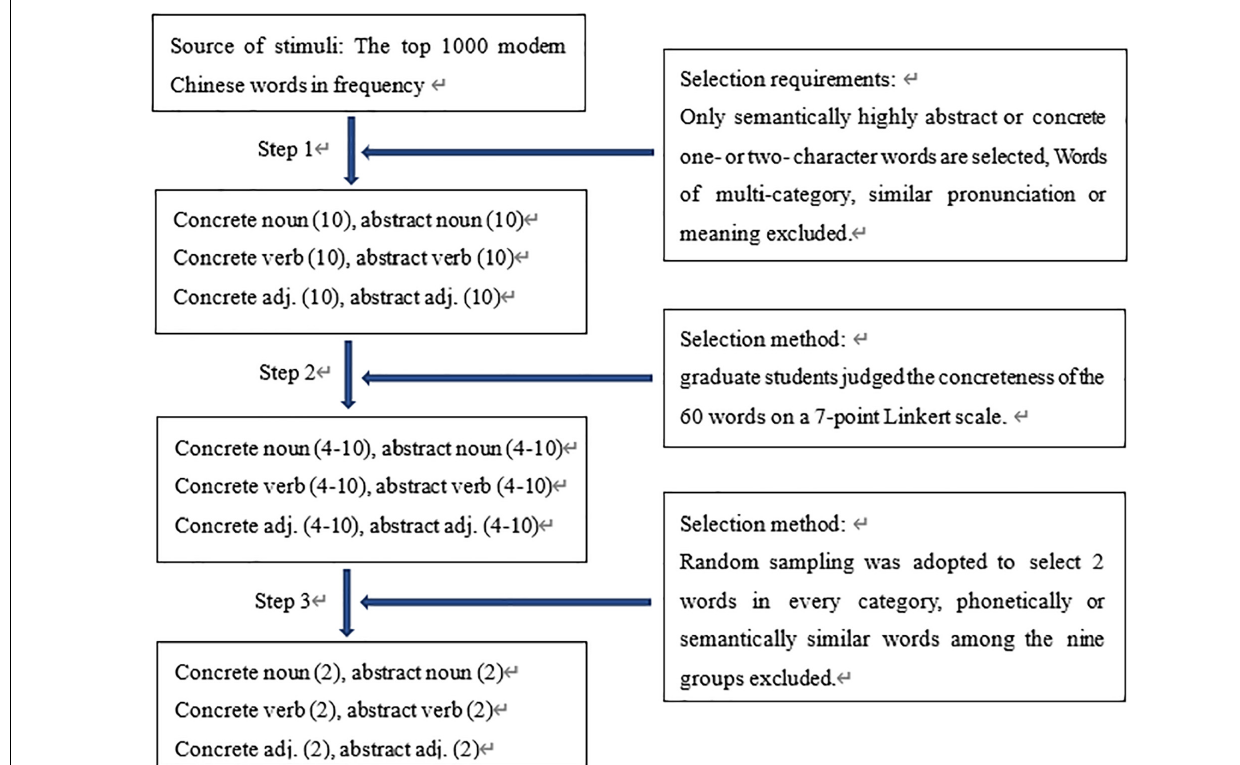
FIGURE 1 | The flow chart of the selection of Group 1 stimulus